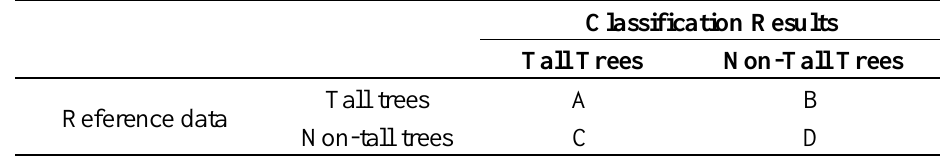
Table 3. The form of the Error Matrix Method (EMM).